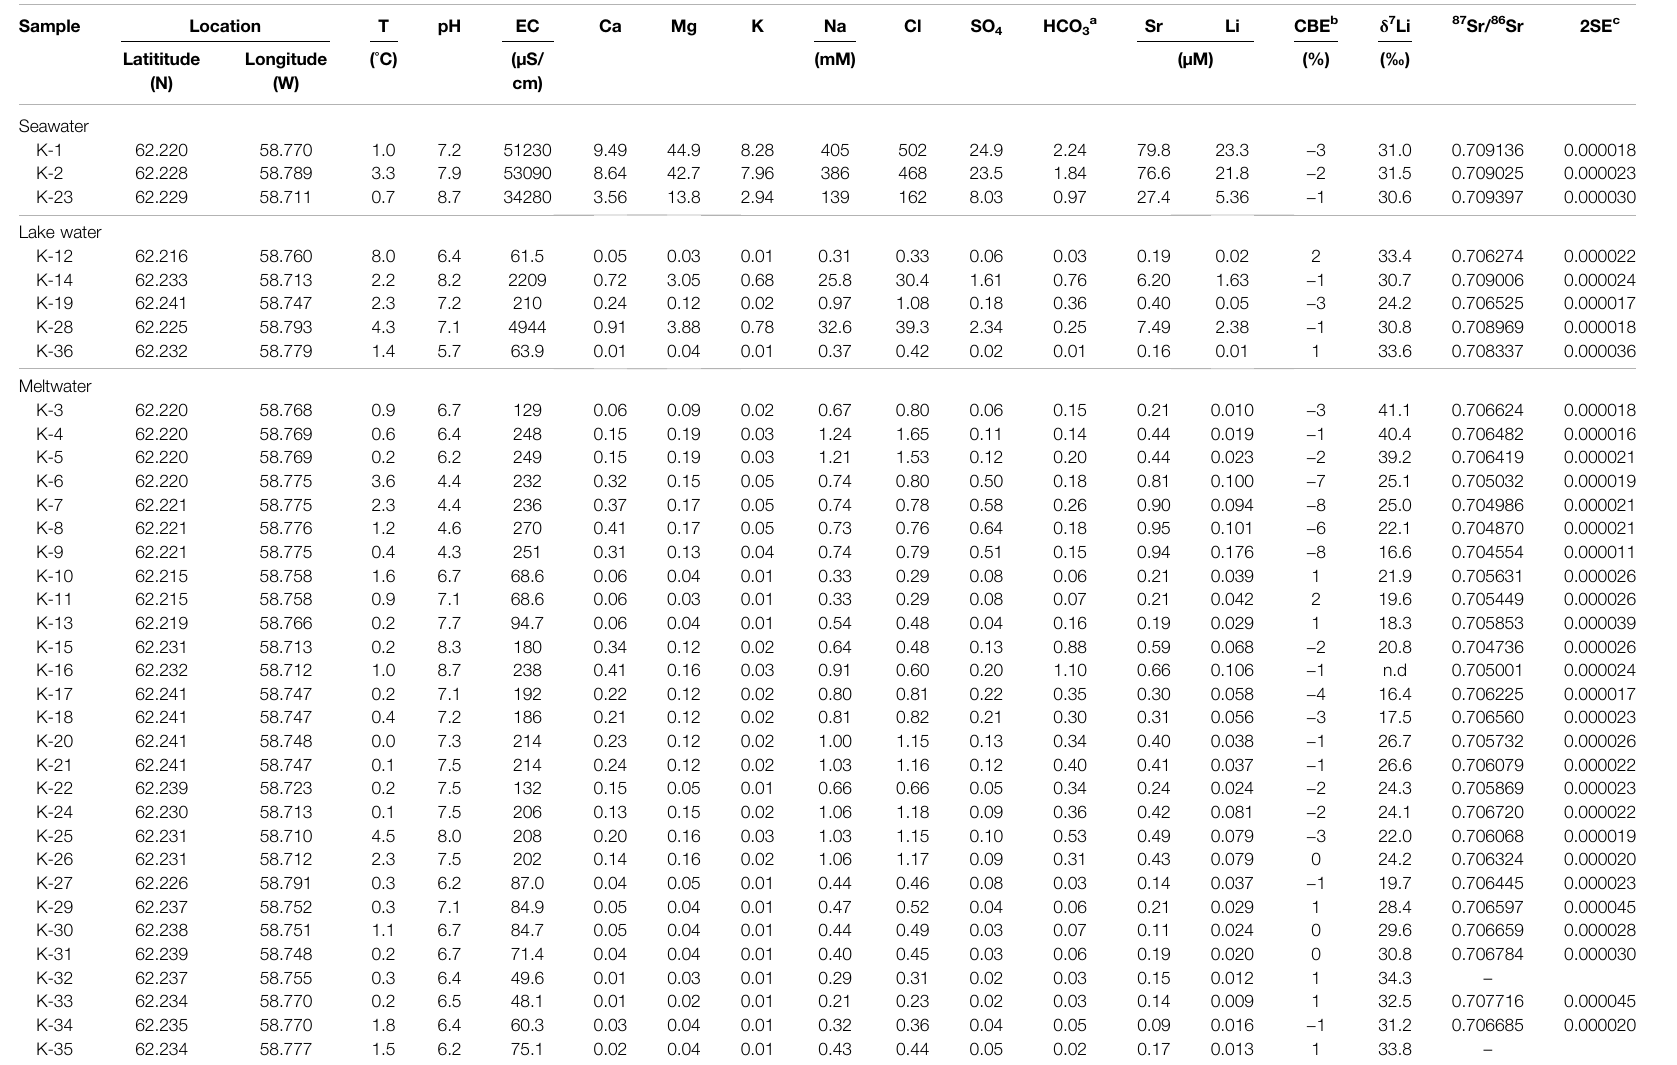
TABLE 1 | Physicochemical and isotopic compositions for water samples.